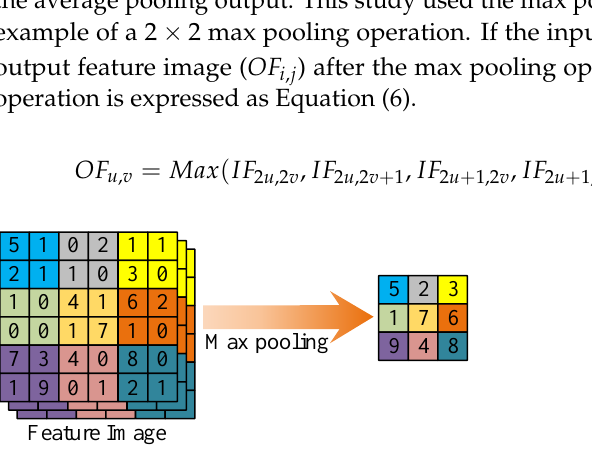
Figure 9. Schematic diagram of pooling layer operation.